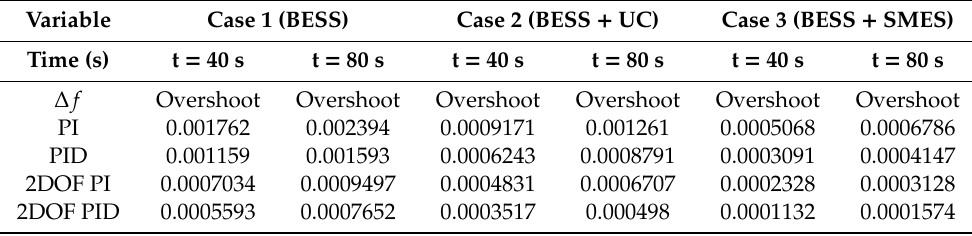
Table 9. Change in the frequency fluctuations ( ∆ f in Hz) of the proposed system for di ff erent